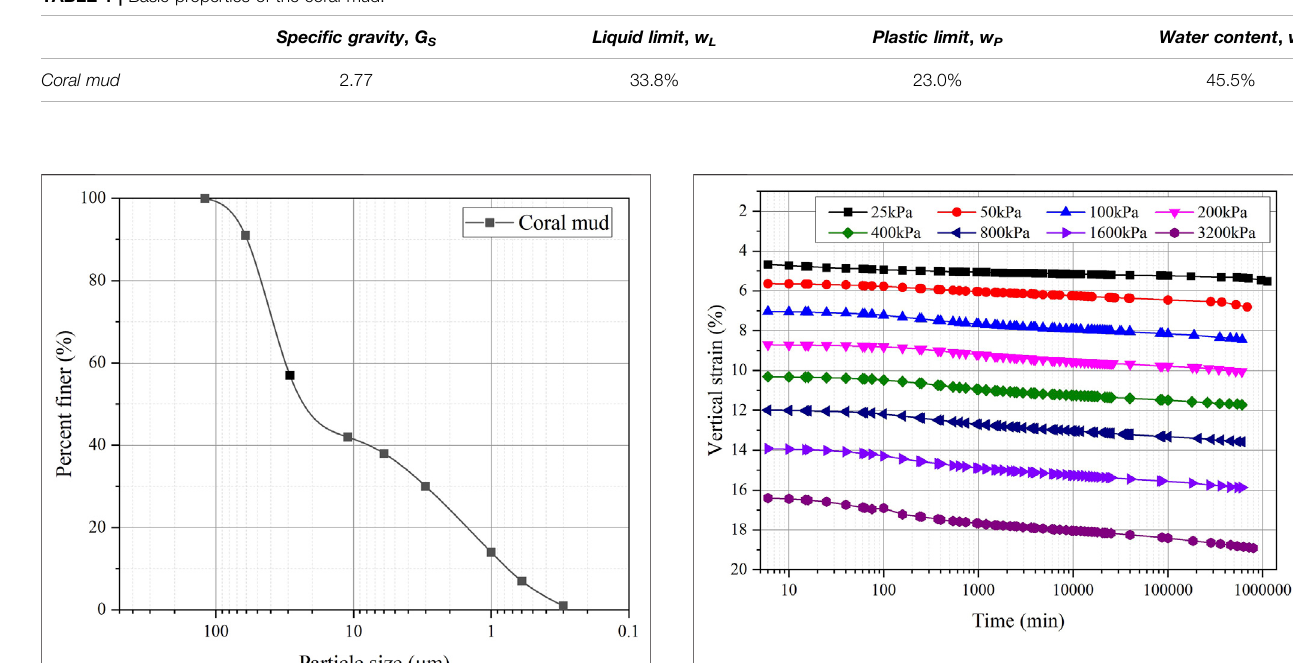
FIGURE 3 | Relationship of vertical strain and time (log-scale) of coral mud.